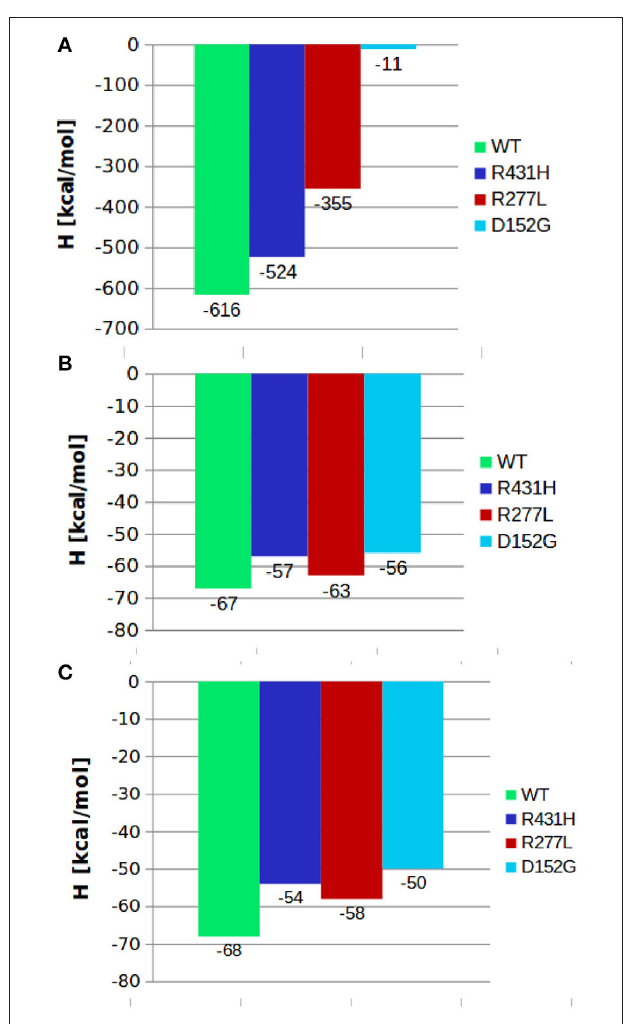
FIGURE 2 | Comparison between the binding enthalpies of various mutants and the wild type CYP51A1 and (A) POR; (B) lanosterol; (C) lanosterol in complex with